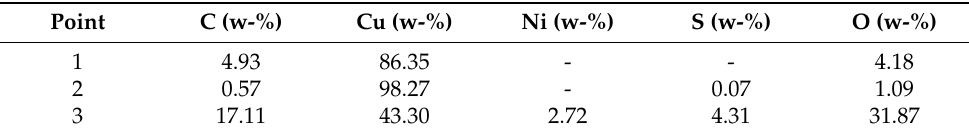
Figure 8. Micrograph of the IIE-2 cathode cross-section. ( a ) represents the SE micrograph, and ( b ) is a BSE micrograph with EDS analysis points (1–3) marked. Numbers indicate the analysis points in Table 8. Table 8. EDS analysis results from points shown in Figure 8b. Traces of carbon are from graphite but also from the SEM chamber, as carbon is a common coating material for poorly conductive samples.